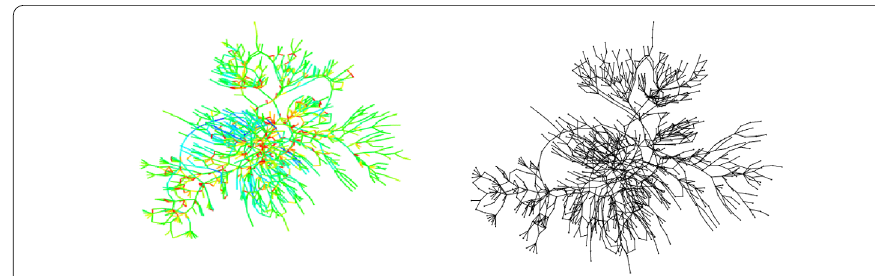
Figure 3 1138_bus, left: result from [14], right: our result